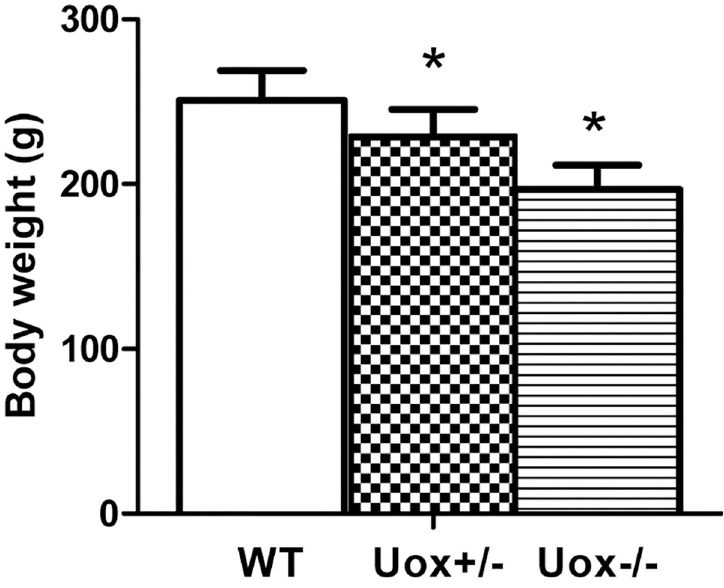
Fig 1. Body weight of the Uox -/- rats at the age of 45 days (mean ± SD, n = 6 (WT), or 10 (Uox +/- and Uox -/- )). � P < 0.05, vs Uox +/- rats, one-way ANOVA.